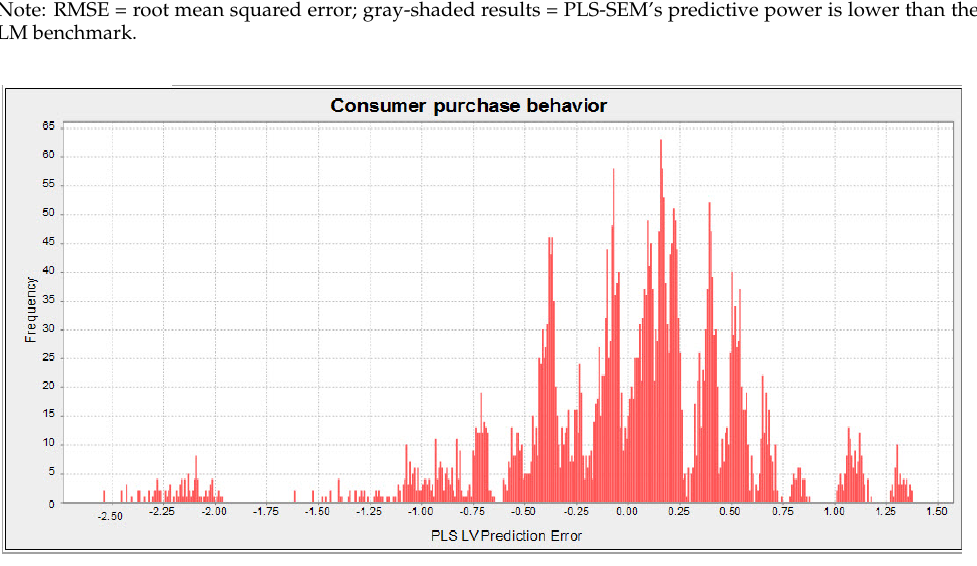
Table 5. Results of research hypotheses and model fit.